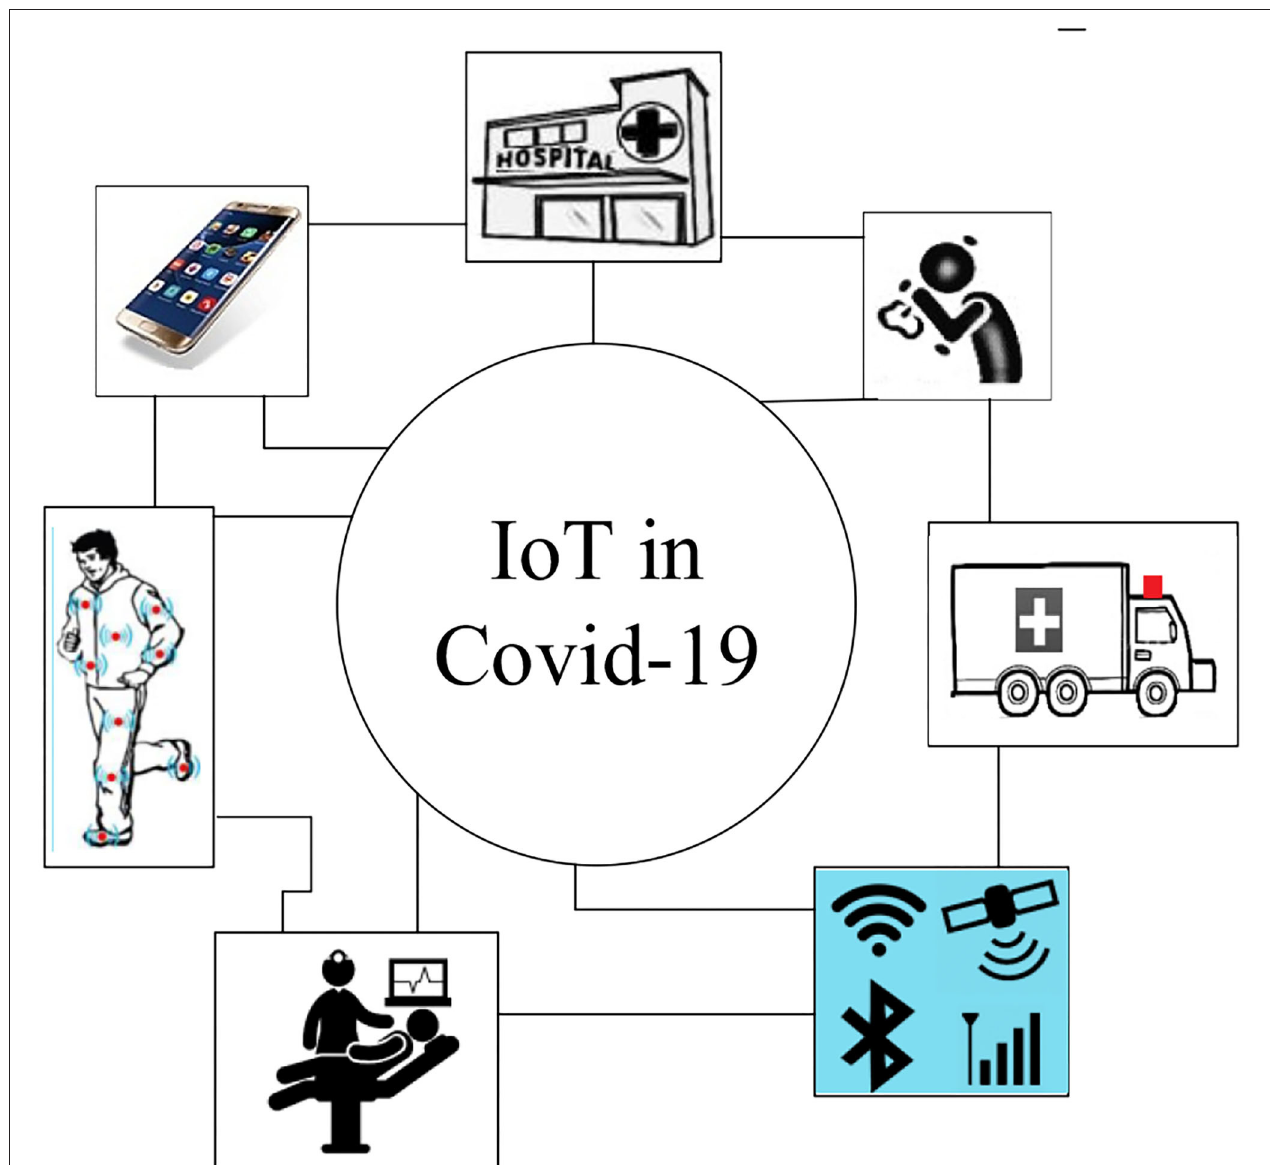
FIGURE 1 | Applications of IoT in